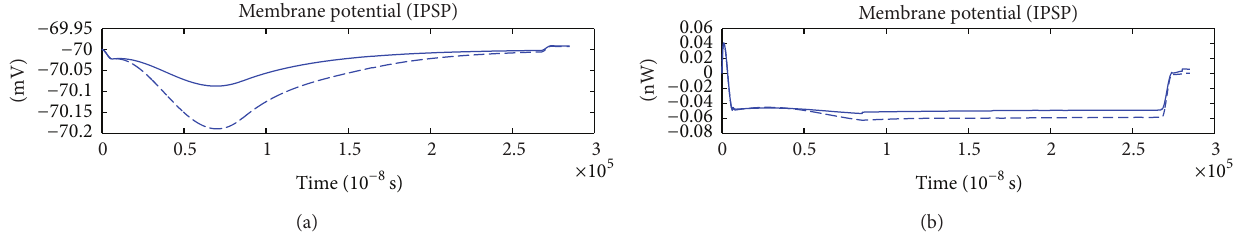
Figure 25: The IPSP and the corresponding energy function. 𝑟 0𝑚 = 0.0001 Ω , 𝑟 1𝑚 = 0.1 Ω , 𝑟 2𝑚 = 1000 Ω , 𝑟 3𝑚 = 0.1 Ω , 𝑟 𝑚 = 1000 Ω , = 1 𝜇 F, 𝐿 = 50 𝜇 H, 𝑖 = −0.7 𝜇 A, and 𝑄 = 4 × 10 −7 𝜇 𝐶 𝑚 𝑚 0𝑚